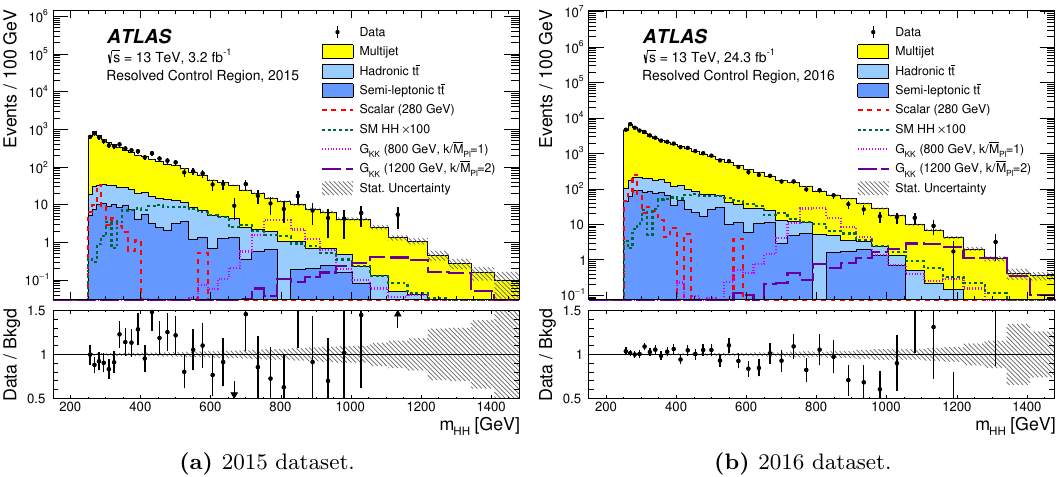
Figure 3. Distributions of m 4j in the control region of the resolved analysis for (a) 2015 data and (b) 2016 data, compared to the predicted backgrounds. The hatched bands represent the statistical uncertainties. The expected signal distributions of G KK resonances with masses of 800 and 1200 GeV, a 280 GeV scalar particle and SM non-resonant HH production ( (cid:2) 100) are also shown. The scalar sample is normalized to a cross section times branching ratio of 2.7